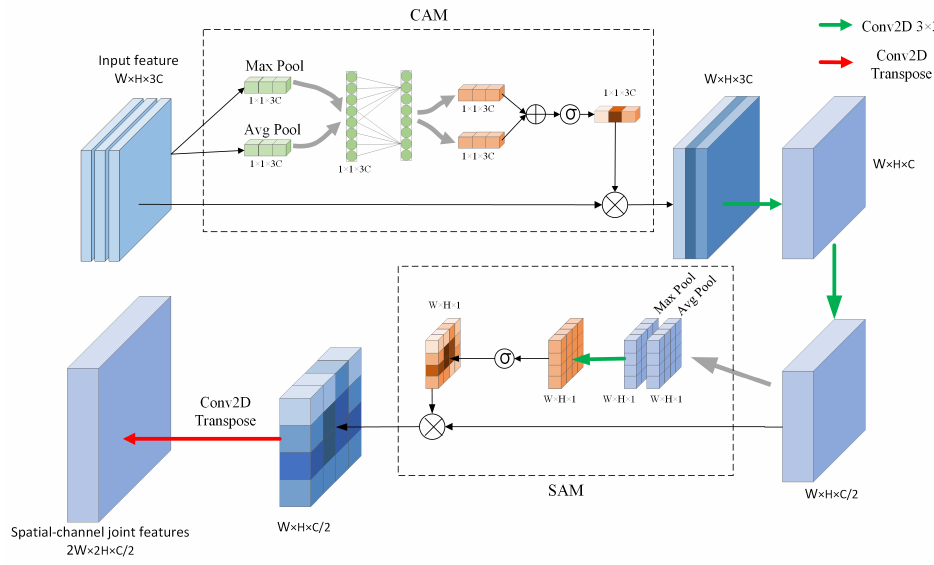
Figure 4. Structure of Upsampling Module